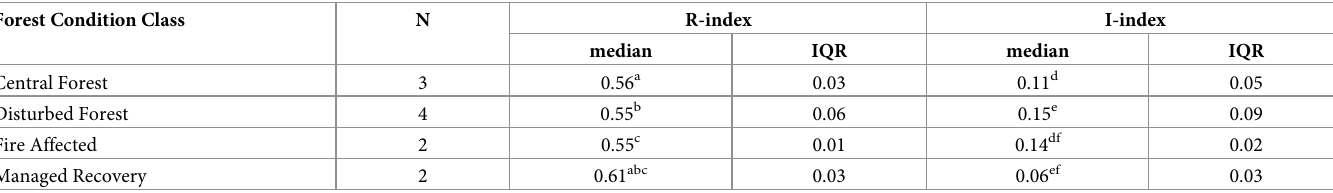
Table 5. R- and I- index median and interquartile range (IQR) for combined below water table and deeper layers for the four forest condition classes. Significant pairwise Wilcoxon tests with Bonferroni adjustments share the same subscript letter. © University of Nottingham/ British Geological Survey © UKRI. Forest Condition